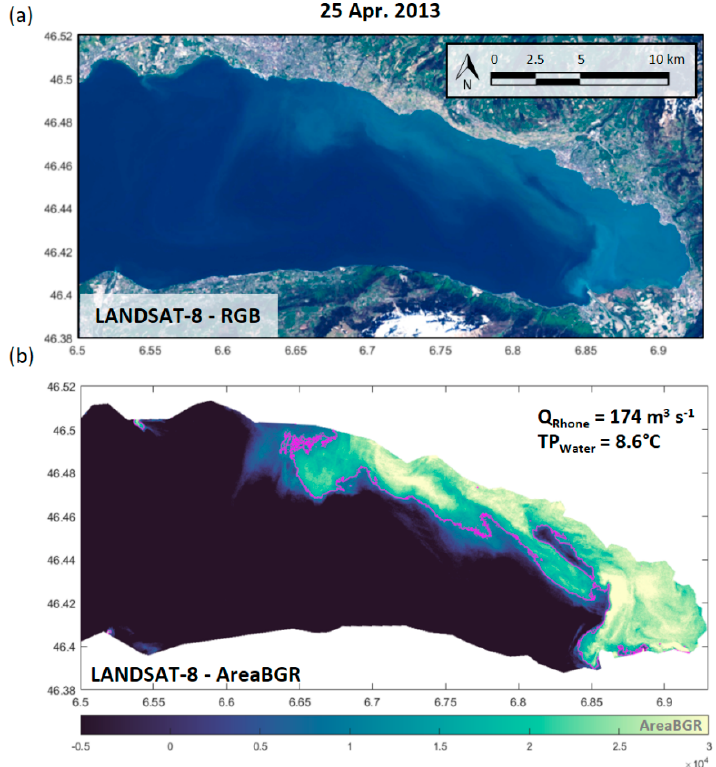
Figure 3. ( a ) Landsat-8 RGB image of Rhone inflow at the lake’s surface on 25 April 2013. ( b ) False- positive AreaBGR index caused by the spread of the Rhone inflow at the surface when the lake is unstratified. The area’s delimitation based on the area threshold of AreaBGR = 13000 is shown in magenta. The Rhone discharge and the lake’s surface temperature corresponding to the image’s date are specified.